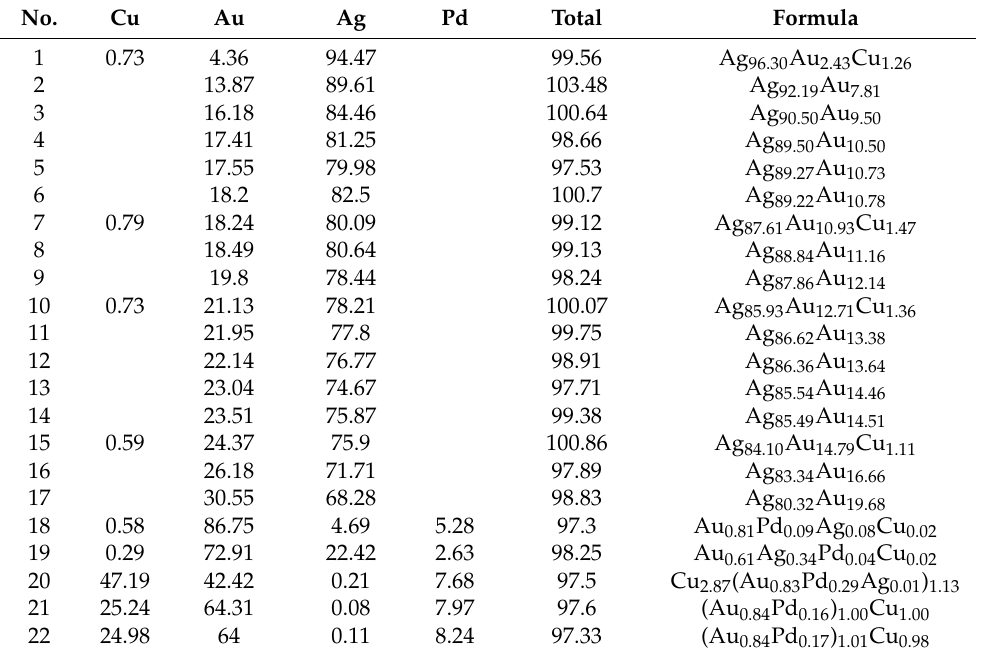
Table 10. Mineral compositions in the system Au-Ag-Pd-Cu in the Southern 2 orebody, wt %.